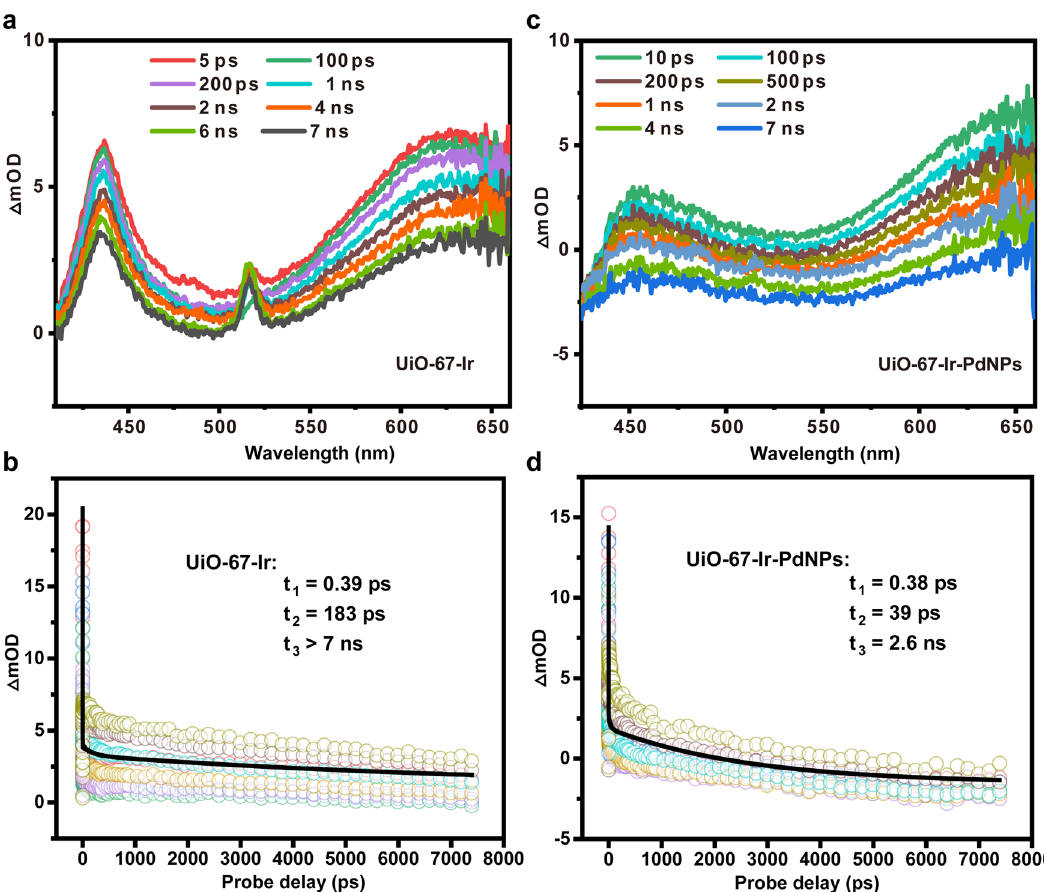
Fig. 5 fs-TA characteristics of the selected catalysts. fs-TA spectroscopy of a UiO-67-Ir and c UiO-67-Ir-PdNPs. fs-TA decay kinetics of b UiO-67-Ir and d